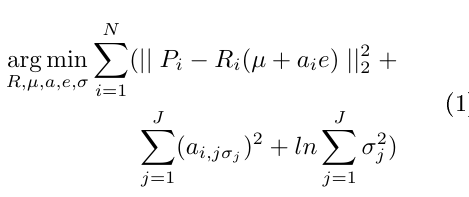
to minimize the following estimate as Eq.